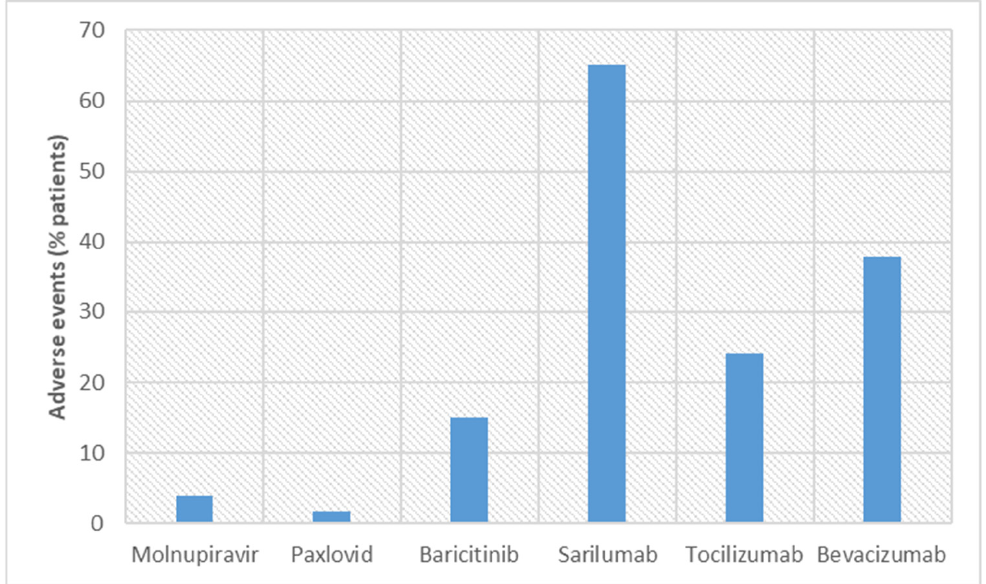
Figure 2. Comparison of adverse events observed in COVID-19 patients in clinical trials conducted with new discovered molecules.